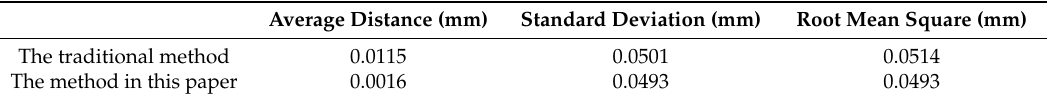
Figure 8. Geomagic studio sphere fitting comparison. ( a ) The fitting result of the traditional method ( b ) The result of the method in this paper. Table 2. Data comparison of fitting results.